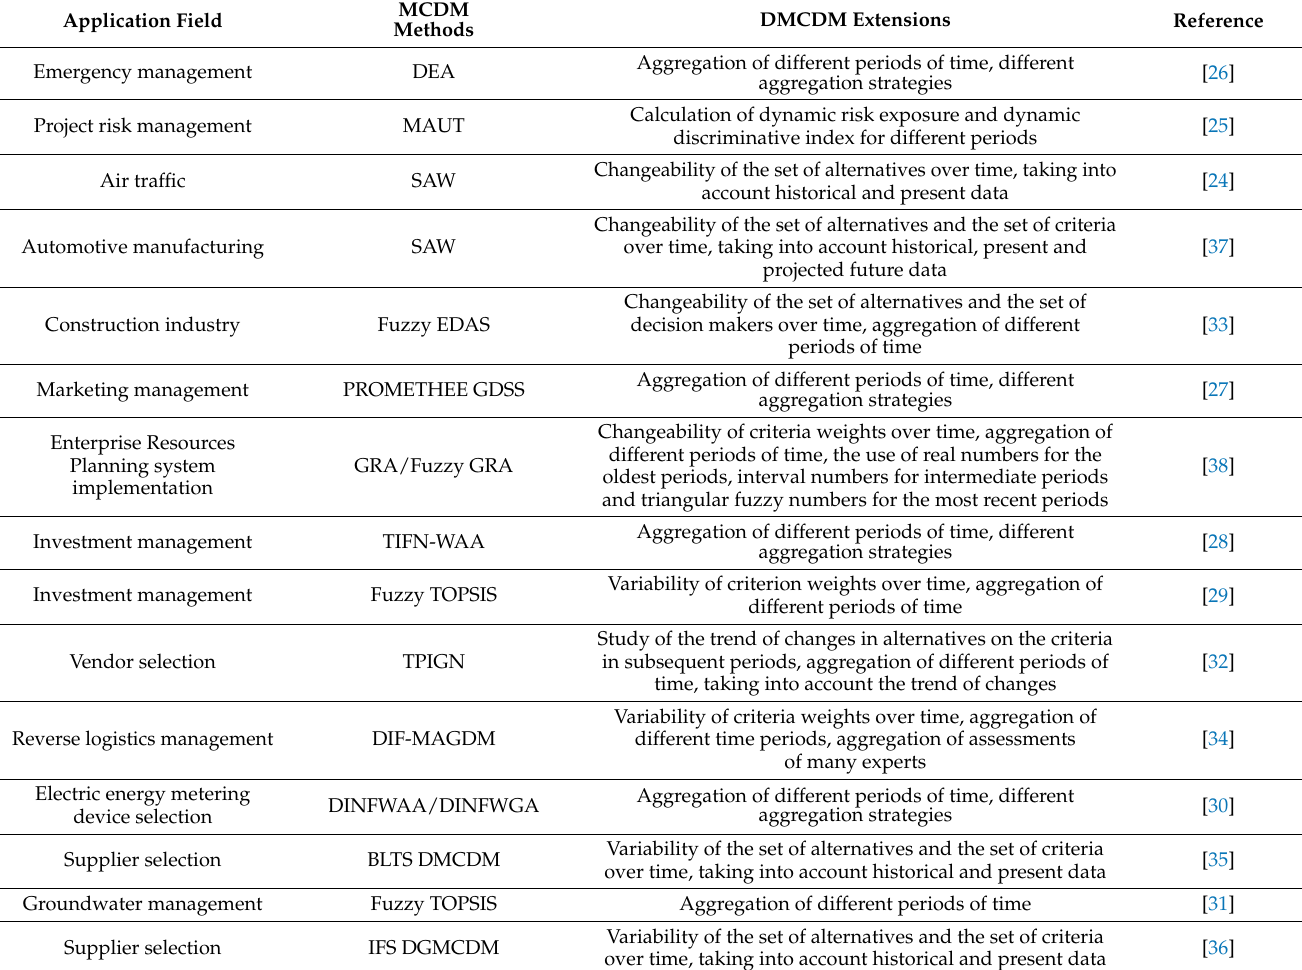
Table 1. Publications and decision problems in which DMCDM approach was